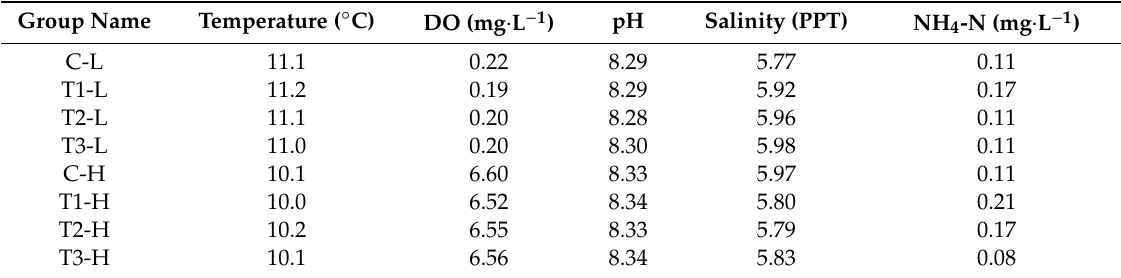
Table 1. Mean values of partial physicochemical parameters of sediments in the experimental coastal wetland system (in group name, letter L: submerged; H: periodically submerged). n =